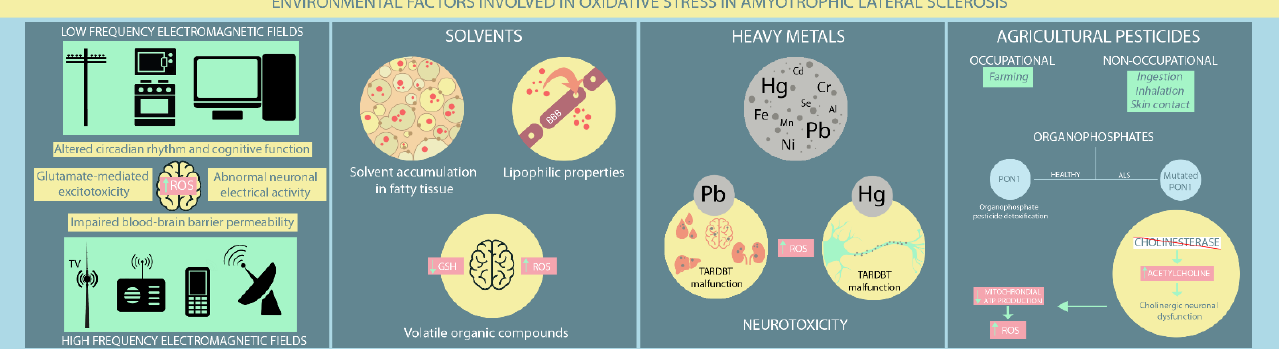
Figure 2. Environmental risk factors involved in oxidative stress in ALS patients. (ROS: reactive oxygen species; Hg: mercury; Pb: lead; Cd: cadmium; Cr: chromium; Se: selenium; Fe: iron; Mn: manganese; Ni: nickel).